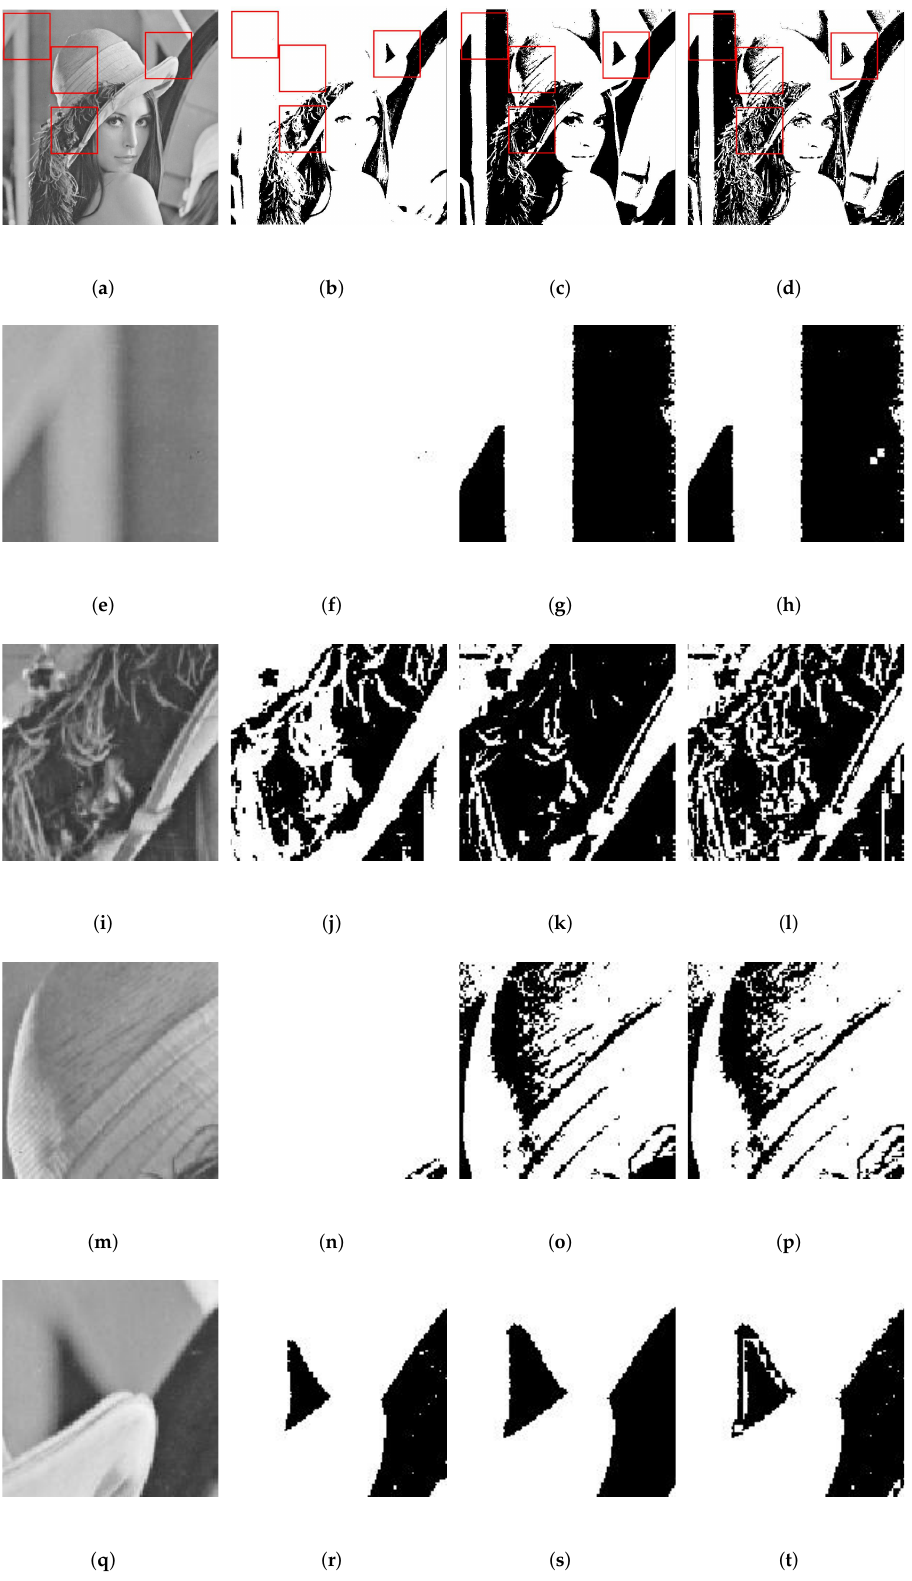
Figure 4. Lena image segmentation renderings and partial enlarged images under different algo- rithms. ( a ) is the original image of Lena, ( b ) is the segmentation effect of the rough set method, ( c ) is the segmentation effect of the PSO method, ( d ) is the combined segmentation effect of the two methods, ( e – t ) are the corresponding partial enlarged